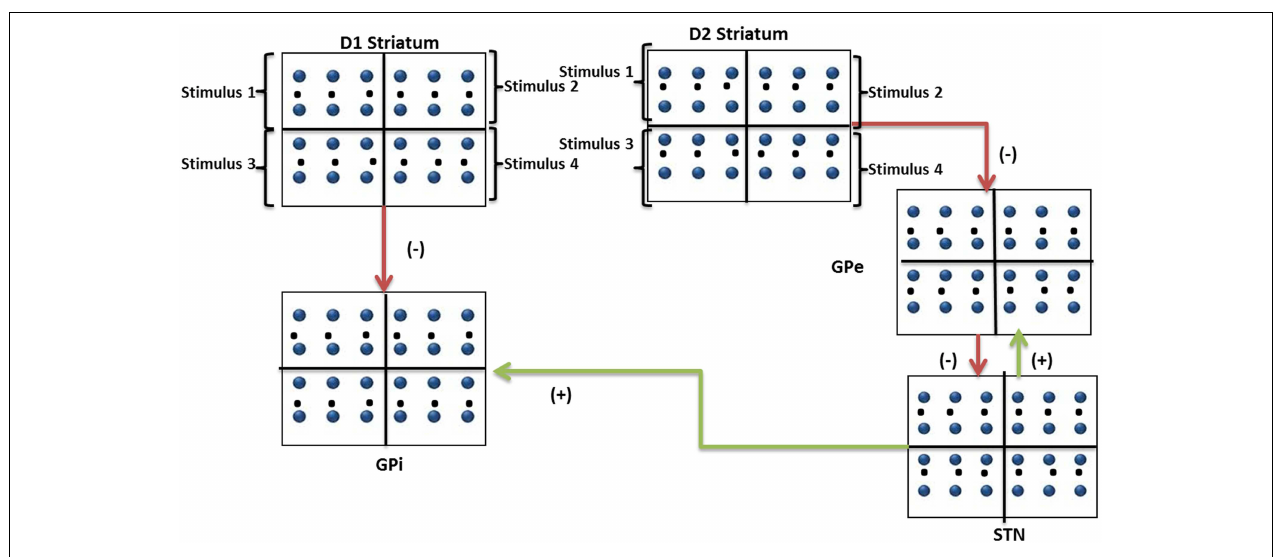
projections to GPi and GPe networks. Stimulus #1, Stimulus #2, Stimulus #3, and Stimulus #4 are the 4 arms whose saliencies are represented in their cortico-striatal